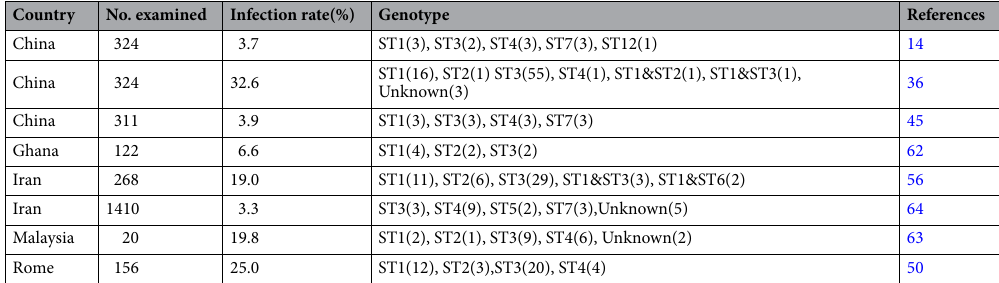
Table 4. Genotype distribution of B. hominis in HIV/AIDS patients